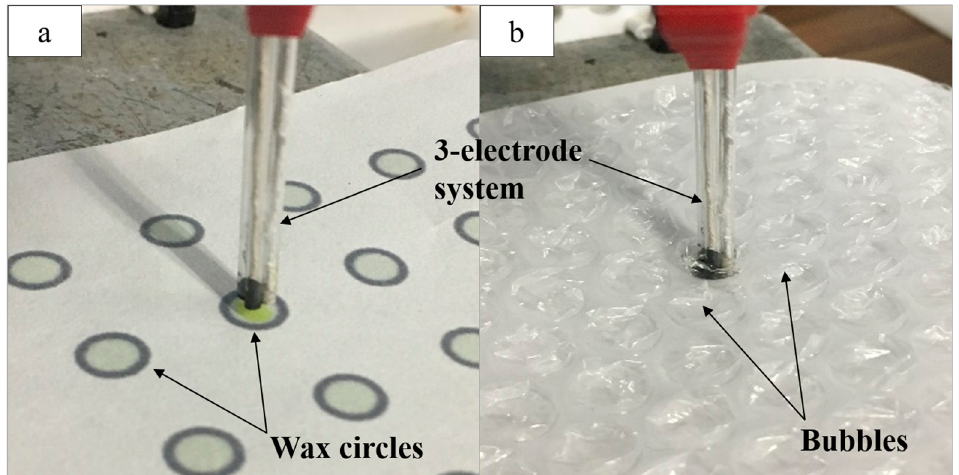
glucose in solution (12 µL) spotted onto the wax-printed circles; ( b ) the electrode system used for acetylthiocholine (ATC) detection in solution (30 µL) spotted into bubble wrap.